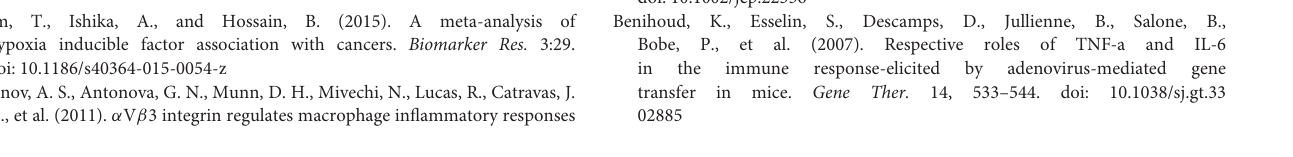
Supplementary Figure 1 | Boxplot of genes analyzed with qPCR. The expression pattern within the ‘radiation-in-normoxia’ and ‘radiation-in-hypoxia’-profiles is comparable to the pattern found in the whole